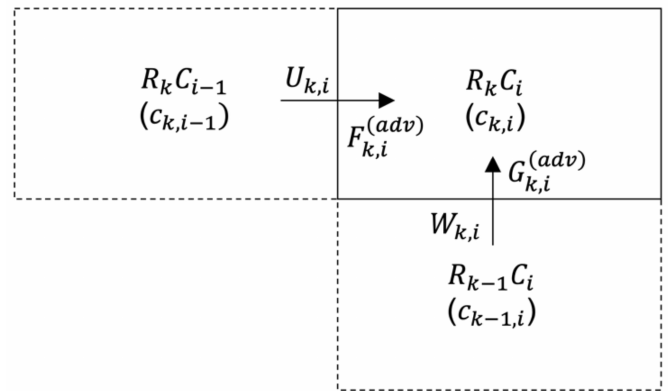
Figure 4. Schematic of the horizontal and vertical advection fluxes of a pollutant into box R k C i , U k , i and W k , i , respectively, calculated according to Equations (3) and